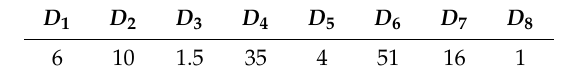
Figure 3. Three types of feeding sheets: ( a ) One transmission line; ( b ) One-step impedance transmission line; ( c ) Two-step impedance transmission line. Table 1. Dimensions of the feeding sheets (mm). Table 1. Dimensions of the feeding sheets (mm).